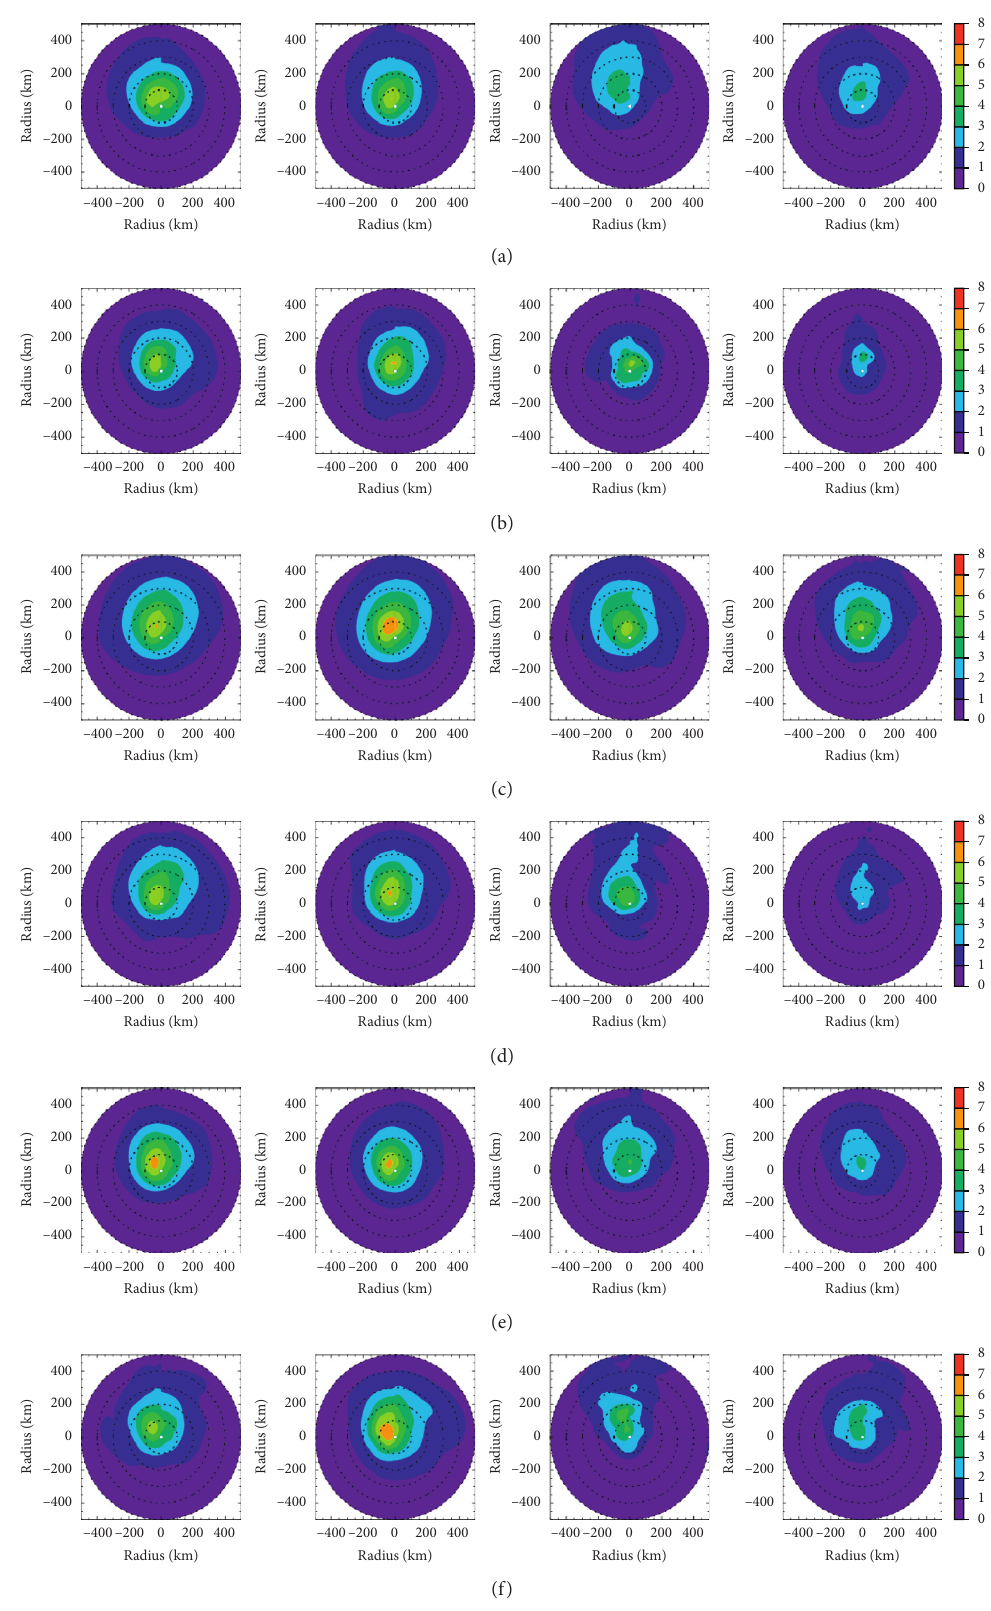
Figure 3: The composite shear-relative rain rate (mm hr − 1 ) for (I) off-shore, (II) preland, (III) in-land with high-PV, and (IV) in-land with low-PV over (a) ATL, (b) EPA, (c) NWP, (d) NIO, (e) SIO, and (f) SPA. The shear direction rotated clockwise with 0 ° pointing to the